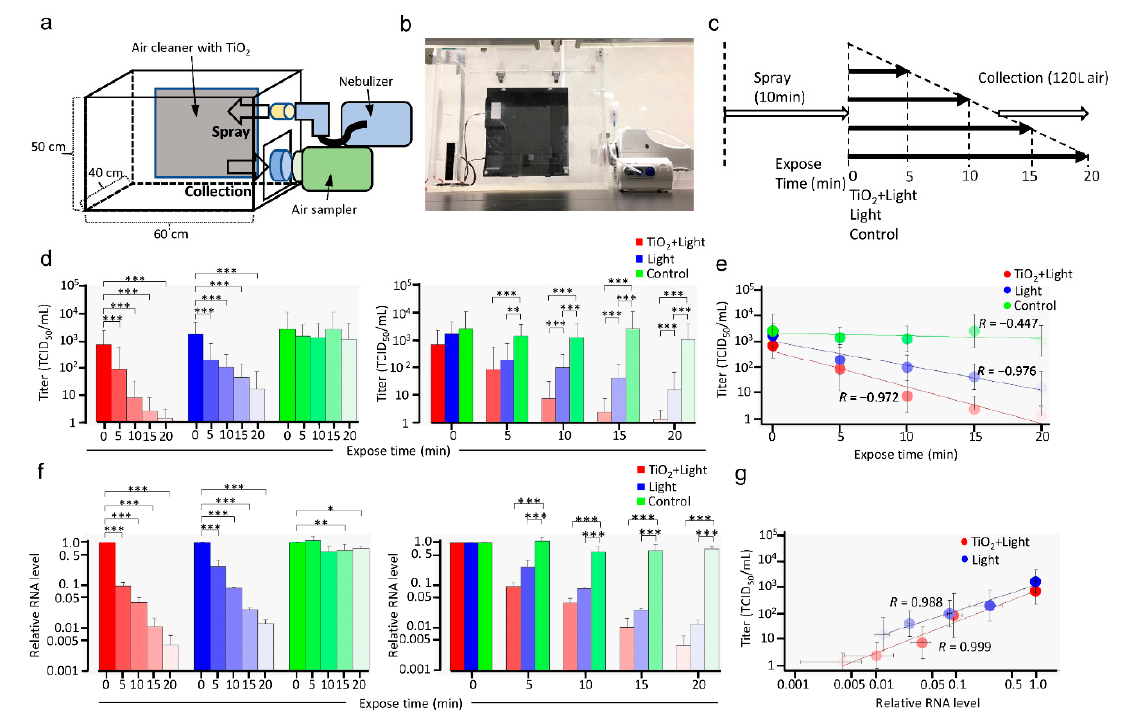
Figure 5. Inactivation of SARS-CoV-2 in aerosols by LED-TiO 2 photocatalytic reaction. Schematic diagram ( a ), image ( b ), and time course ( c ) of the inactivation of SARS-CoV-2 in the aerosol test system. SARS-CoV-2 (2.3 mL) titer of 1.78 × 10 6 TCID 50 /mL was sprayed as aerosol into a 120 L acrylic box using nebulizer for 10 min. Then, air cleaner with TiO 2 -coated sheet and LED light or only LED light was used to circulate SARS-CoV-2 in aerosols. As control, SARS-CoV-2 in aerosol were left without circulation using air cleaner. SARS-CoV-2 in aerosols were captured in gelatin filter using MS8 microbiological sampler with 120 L and the gelatin membrane filter was molten in MEM containing 2% FBS. ( d ) Viral titer of SARS-CoV-2 collected from the gelatin membrane filter was assessed by TCID 50 assay. All values in each group were compared with those of the sample obtained at 0 min by two-way ANOVA with Dunnett’s test (left panel). All values at each time point were analyzed by two-way ANOVA followed by Tukey’s test (right panel). Asterisk indicates a statistically significant difference (* p < 0.05; ** p < 0.01; *** p < 0.001). ( e ) Linear regression analysis to examine the correlation between LED-TiO 2 photocatalytic reaction duration and SARS-CoV-2 infectivity. R indicates the Pearson correlation coefficient. ( f ) Viral RNA was extracted from the gelatin membrane filter and detected by RT-qPCR. All values in each group were compared with those of the 0 min sample by two-way ANOVA with Dunnett’s test (left panel). All values at each time point were analyzed by two-way ANOVA followed by Tukey’s test (right panel). Asterisk indicates a statistically significant difference (* p < 0.05; ** p < 0.01; *** p < 0.001). ( g ) Linear regression analysis to examine the correlation between SARS-CoV-2 infectivity and relative viral RNA level. Each column and error bar represent the mean ± SD of results for two experiments. R indicates the Pearson correlation coefficient.